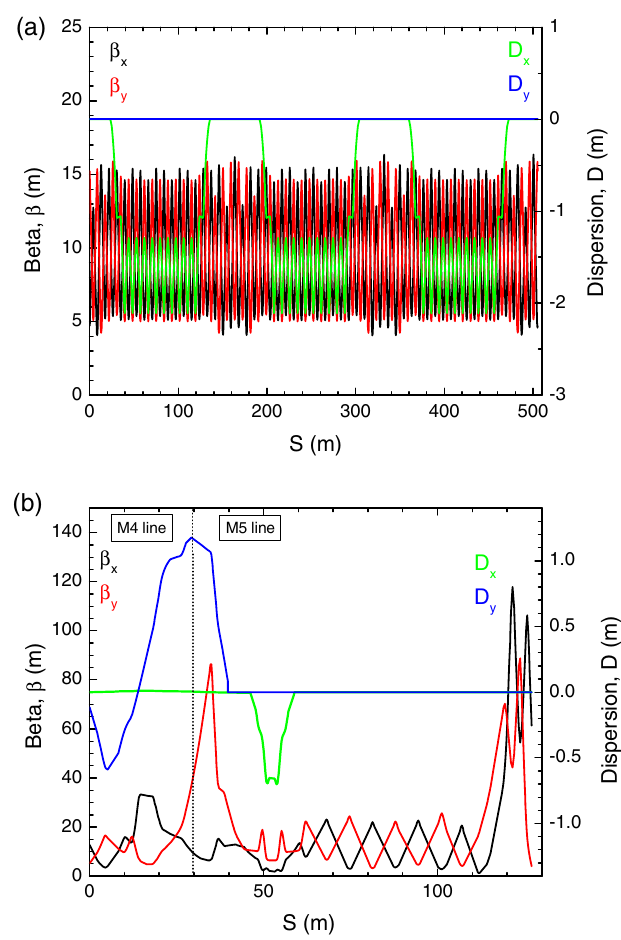
FIG. 4. (a) The optics functions for the DR. (b) The optics functions for the M4-and M5-line, where the M5-line ends at the entrance of the muon storage ring. The lattice is designed to have a transverse acceptance of 40 mm-mrad and a narrow momentum acceptance of Δ p=p ¼ (cid:2) 2 %. The M5 begins at S ≈ 30 . 0 m, a 27.1° horizontal bend string begins at S ¼ 46 . 5 m that provides the proper entry position into the muon storage ring, while a tunable final focus section using four quadrupole magnets begins at S ¼ 119 . 8 m that provides optical matching to the storage